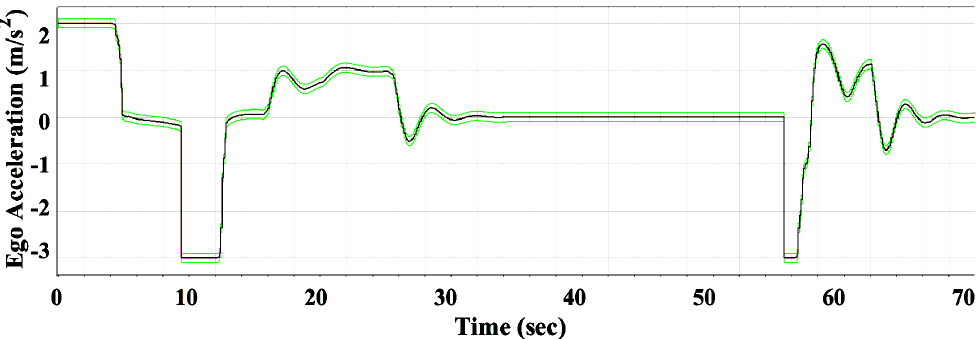
Figure 20. FPGA—Simulink comparison—RL-based controller’s response within the tolerance range.